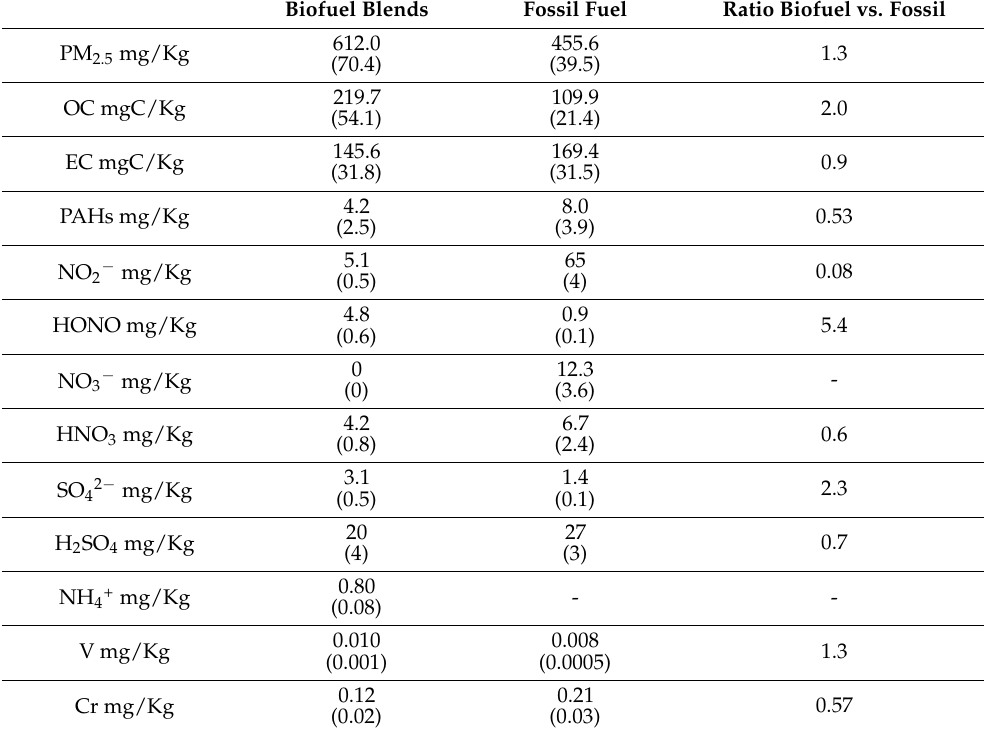
Table A8. Emission indexes obtained from filter samples: data are reported as average for each fuel with the relative quadratic error in